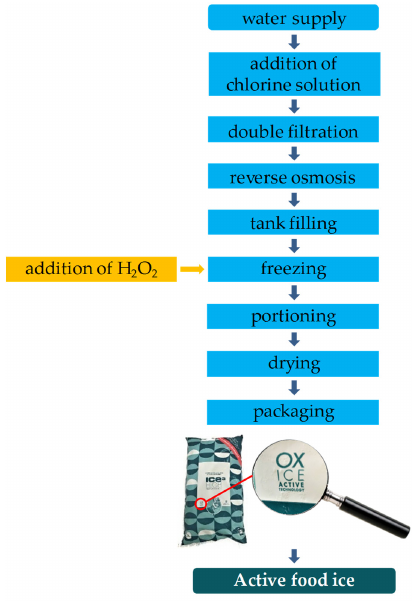
Figure 1. Flow diagrams of active food ice.